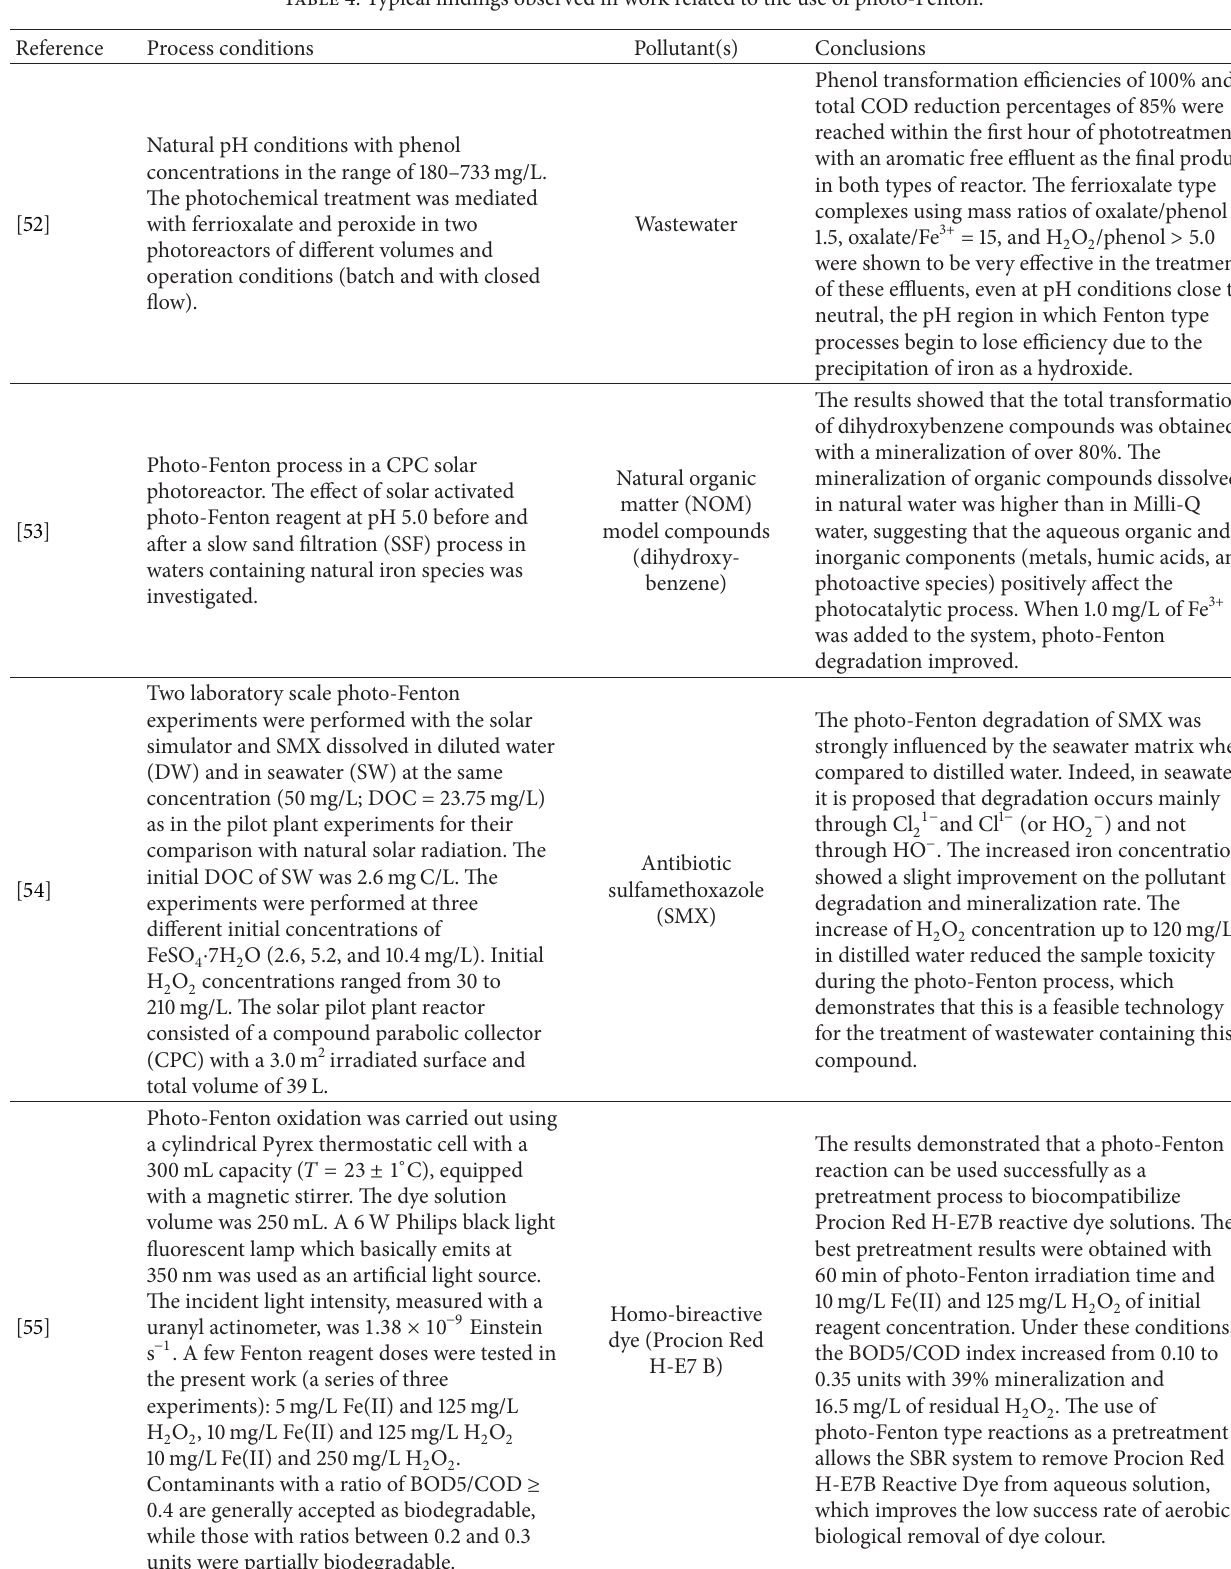
Table 4: Typical findings observed in work related to the use of